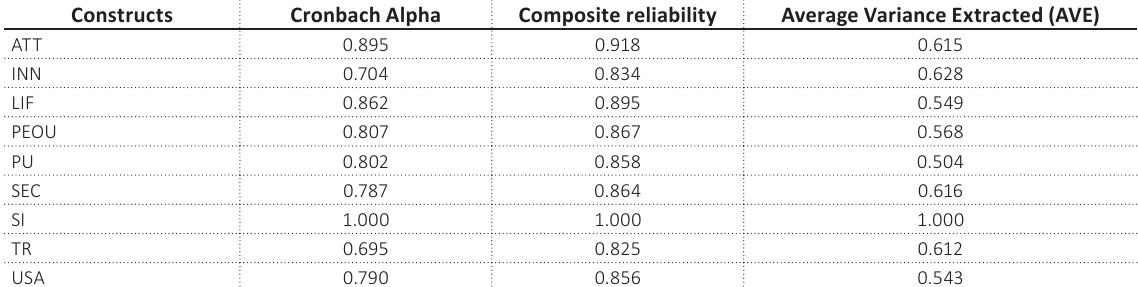
Table 2. Reliability